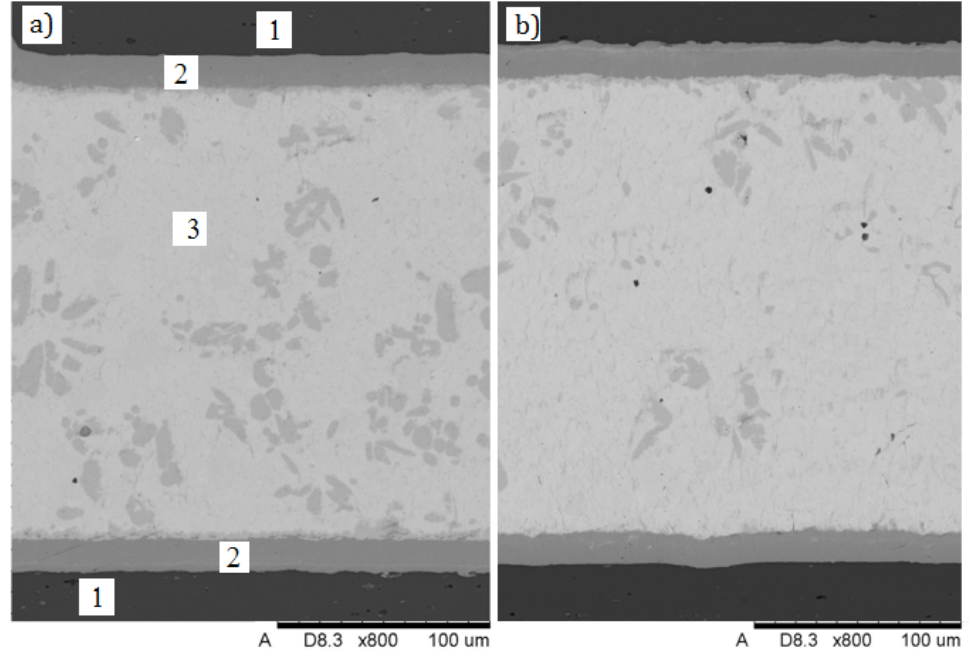
Figure 5. Microstructure of soldered joint made via Cu-Cr interlayer, two different part of joint ( a , b ): 1—substrate (aluminum 7075), 2—Cu-Cr interlayer, 3—solder.